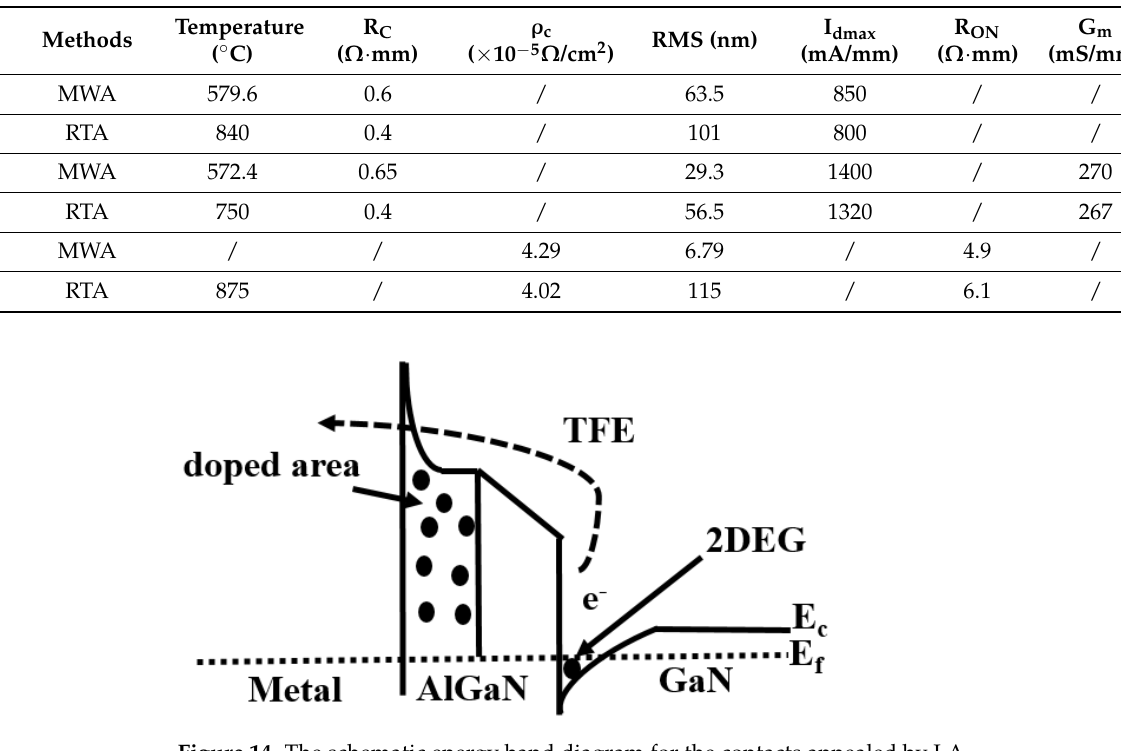
Figure 14. The schematic energy band diagram for the contacts annealed by LA.